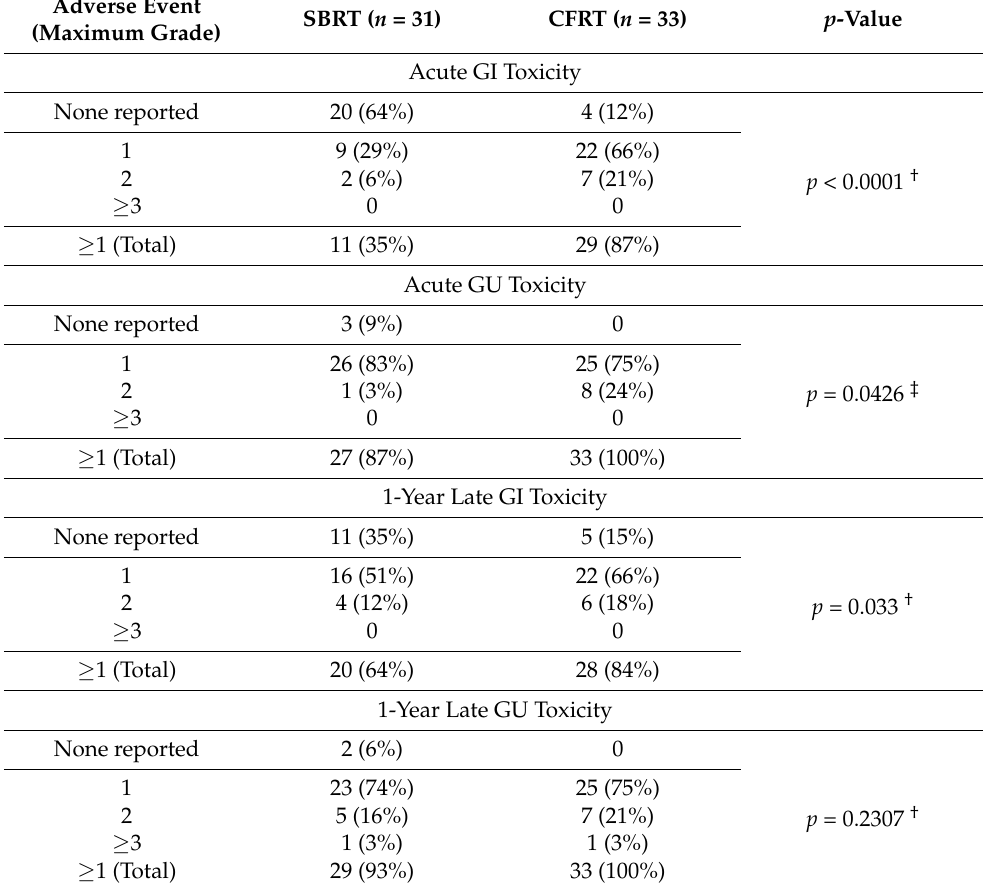
Abbreviations: Gastrointestinal (GI) toxicity, toxicities including abdominal pain, bloating, constipation, diarrhea, fecal incontinence, hemorrhoids, proctitis, rectal hemorrhage, and rectal pain; genitourinary (GU) toxicity, toxicities including non-infective cystitis, hematuria, urinary frequency, urgency, retention, incontinence, and urinary tract pain; SBRT, stereotactic body radiotherapy; CFRT, conventional fractionated radiotherapy. † p for comparison of treatment group of grade ≥ 1 vs. grade < 1; ‡ p for comparison of treatment group of grade ≥ 2 vs. grade <